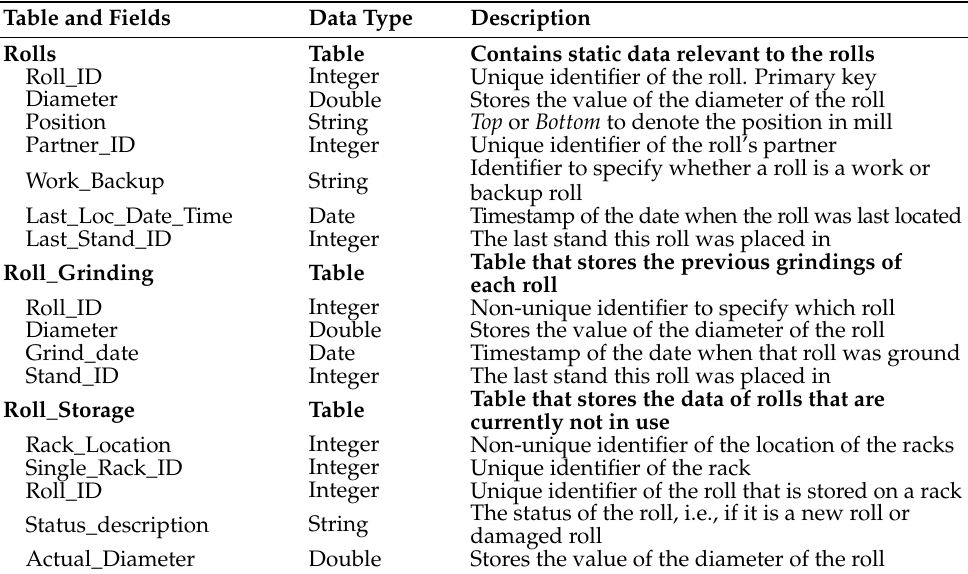
Table 2. Description of all three tables from the data sets. Table and